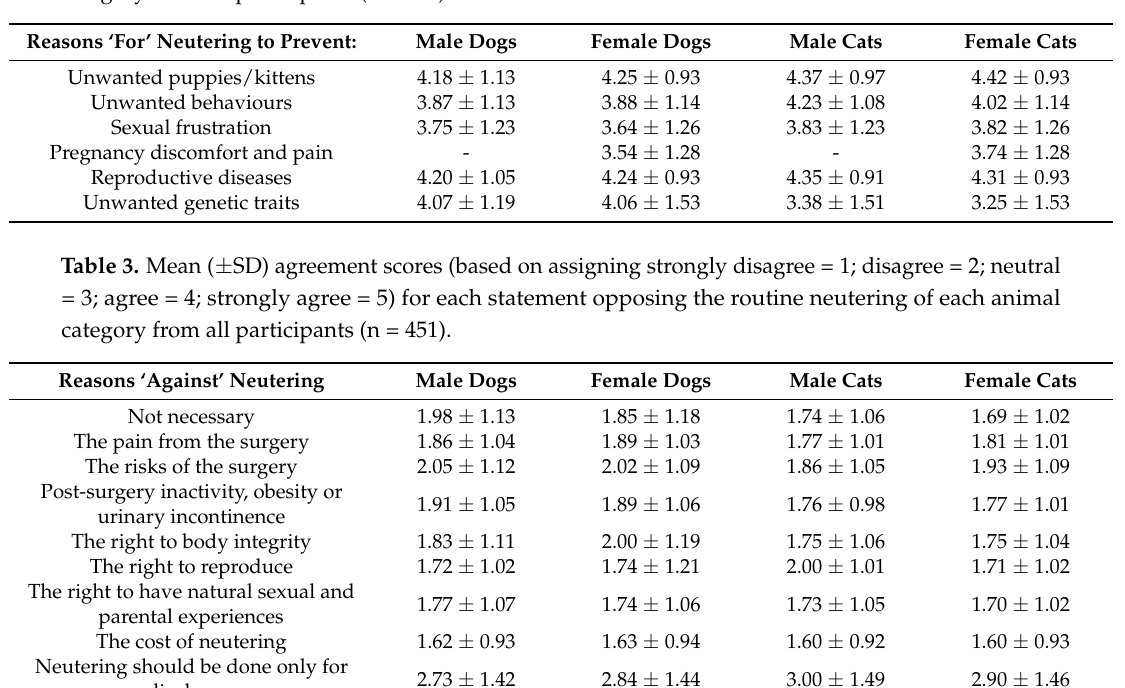
Table 2. Mean ( ± SD) agreement scores (based on assigning strongly disagree = 1; disagree = 2; neutral = 3; agree = 4; strongly agree = 5) for each statement supporting the routine neutering of each animal category from all participants (n = 451).